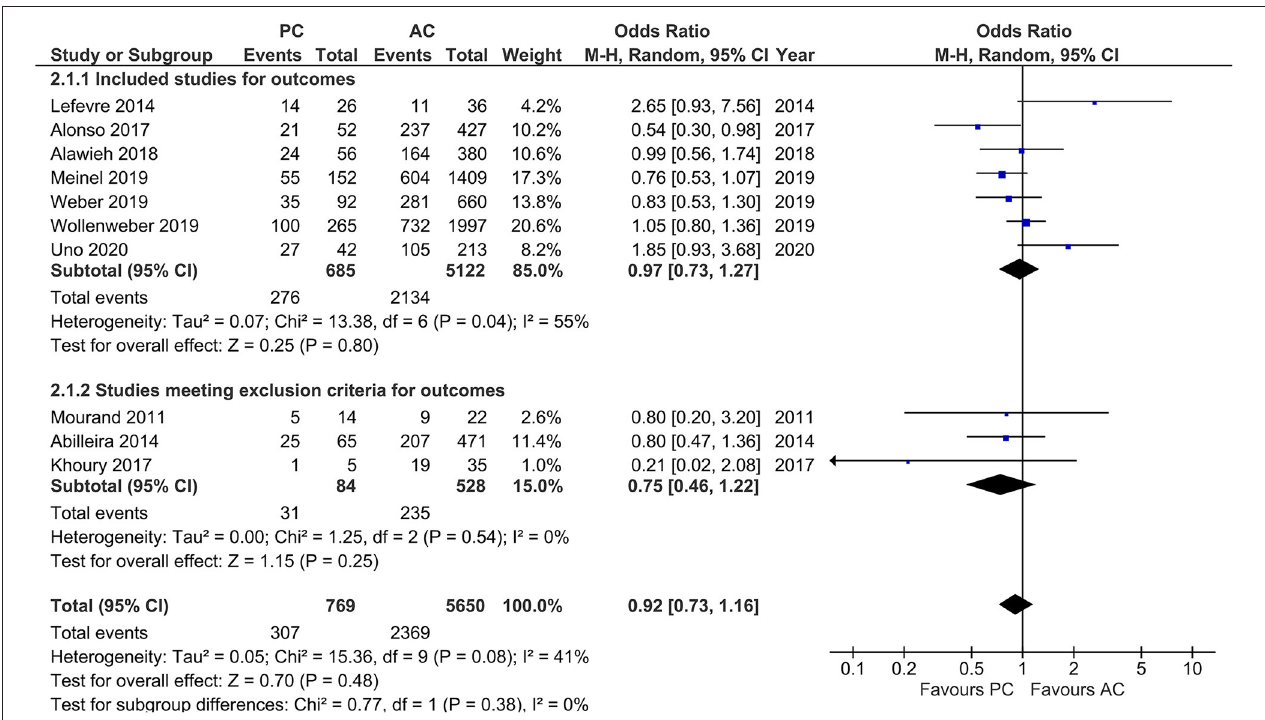
FIGURE 10 | Forest plot comparing “favorable functional outcome (defined as modified Rankin Scale score 0–2) at 90 days” in patients with large vessel occlusion (LVO) in the posterior circulation (PC) vs. anterior circulation (AC) who were treated with endovascular mechanical thrombectomy. Three studies with < 20 PCLVO patients and/or patient recruitment primarily until 2012 were excluded from subgroup analysis. Chi 2 , chi-square statistic; CI, confidence interval; df, degrees of freedom; I 2 , I -square heterogeneity statistic; M-H, Mantel–Haenszel statistic; P , p -value; Tau 2 , estimated variance of underlying effects across studies; Z , Z